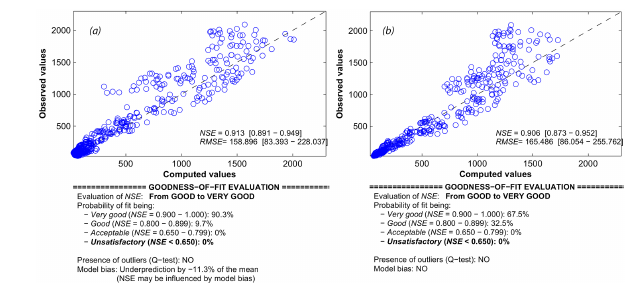
Figure 6. Goodness-of-fit evaluation for validation period (1989– 1997) at the Yermasoyia watershed: (a) UBCANN method and (b) UBCCLA method.